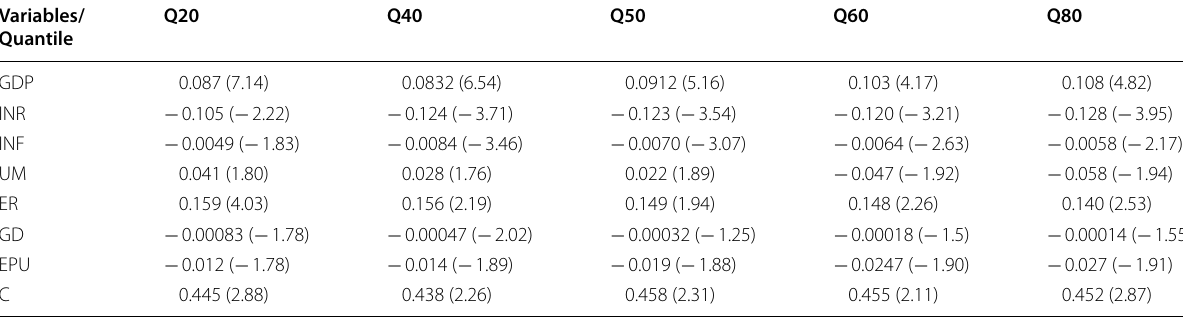
The values within the () symbols show the T statistics Source: Research finding